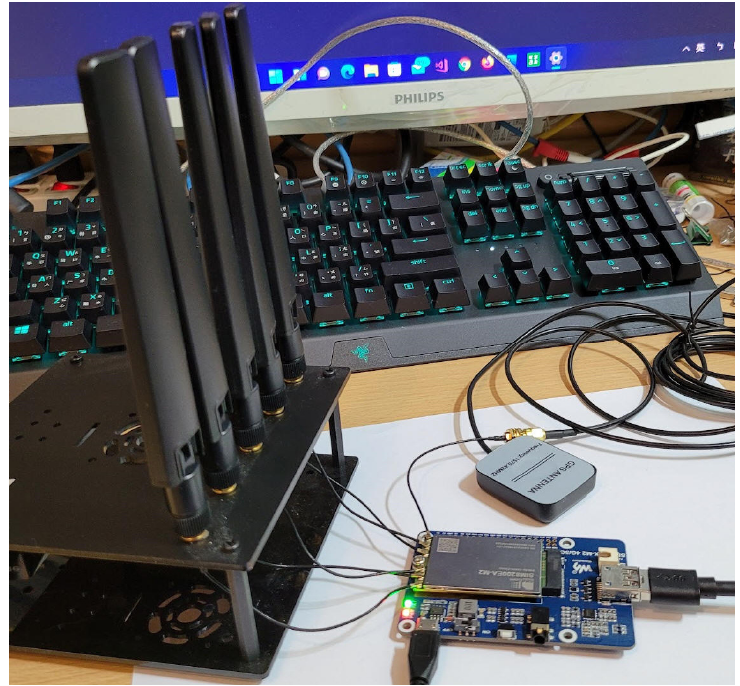
Figure 21. Actual usage of RM500Q-GL.